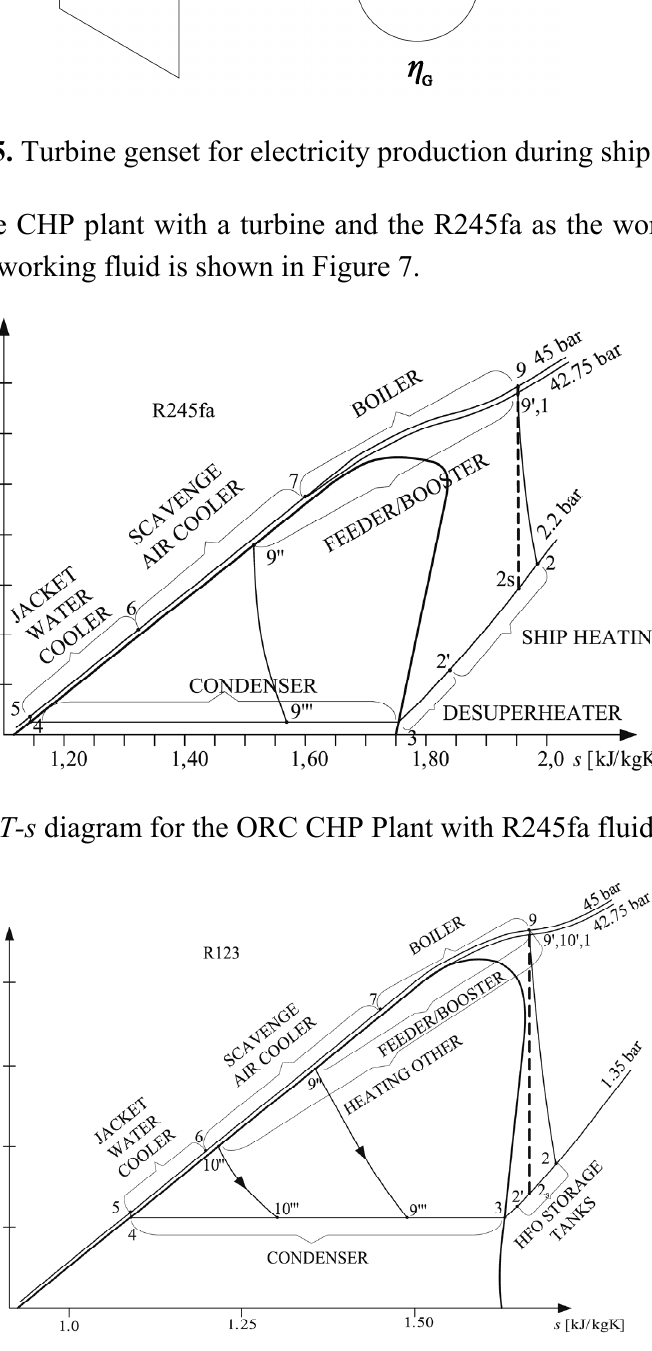
Figure 7. T-s diagram for ORC CHP Plant with R123 fluid